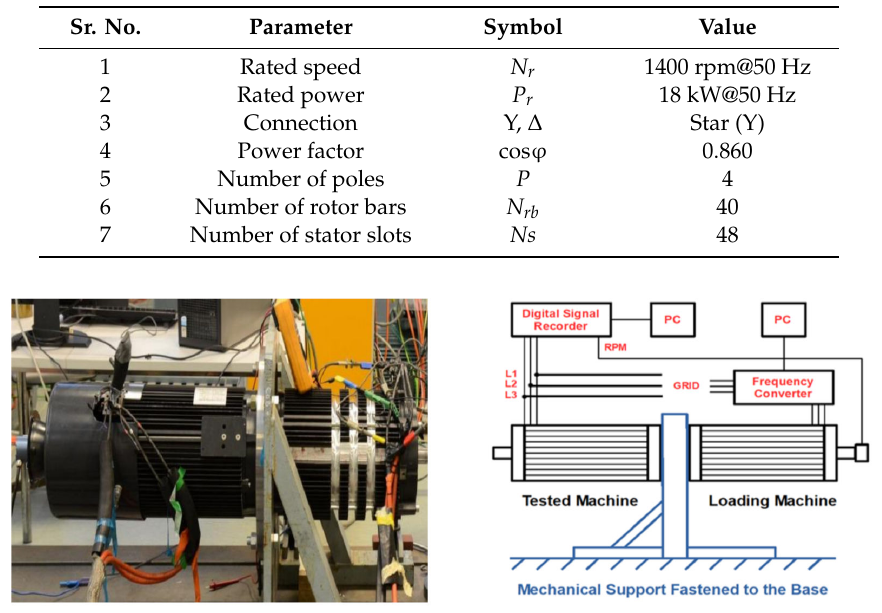
Figure 7. The test rig and its block